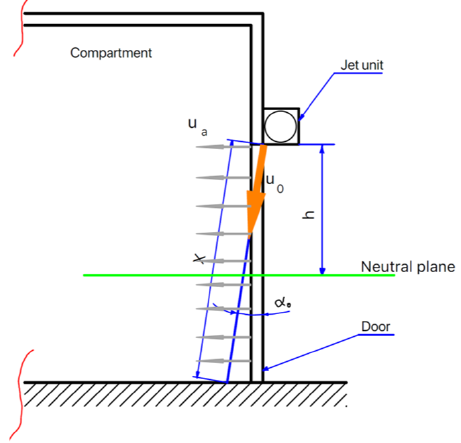
Figure 3. Schematic cross section of the plane jet at the door.